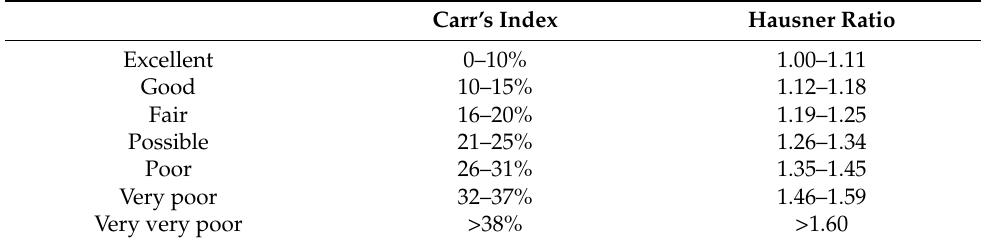
Table 1. Specifications for Carr’s index and Hausner ratio